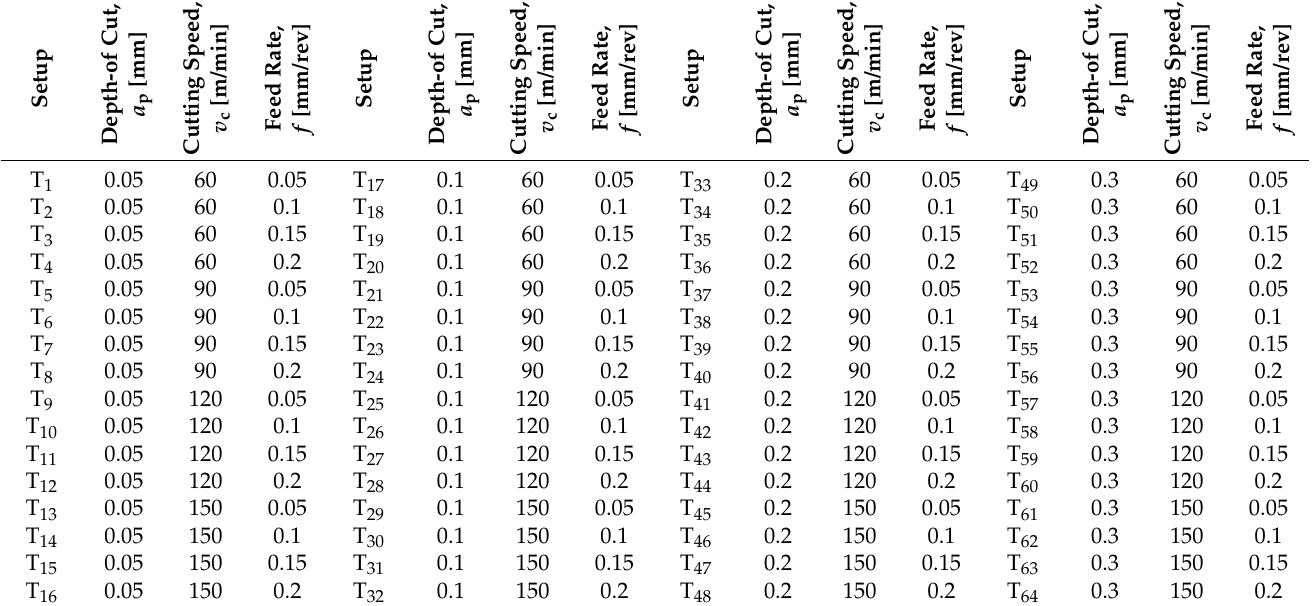
Table 4. Experimental setup and the applied cutting data for hard turning.